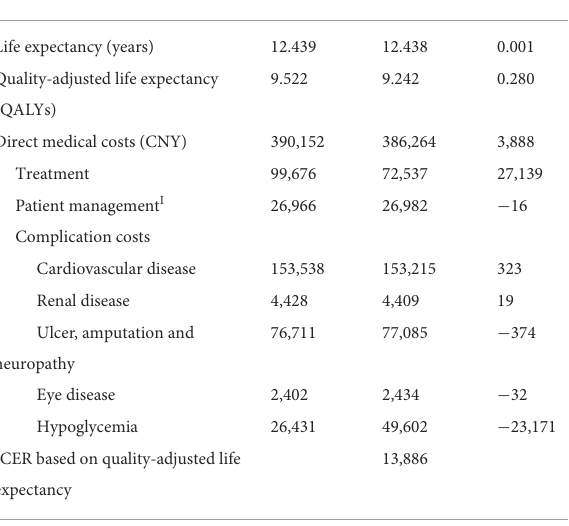
TABLE 1 Base-case analysis. TABLE 2 Cumulative incidence of diabetes-related complications over 30